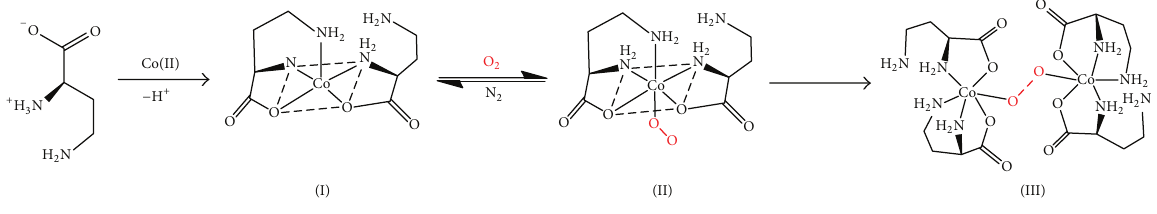
Scheme 1: Oxygenation mechanism for DABA-Co(II) complex with